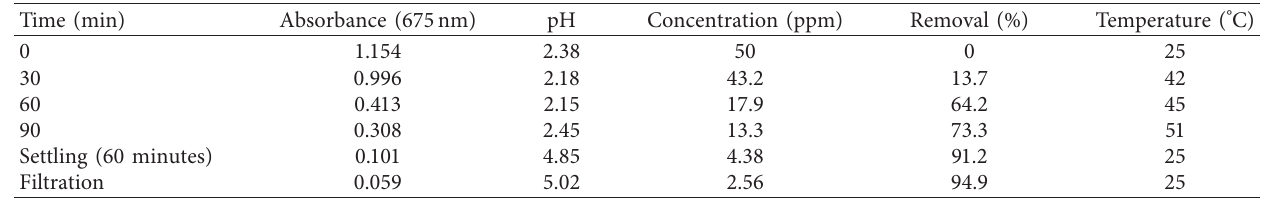
Figure 4: (a) Plot of pH with respect to time over 250min period. (b) Plot of absorbance with respect to time over 250min period. (c) Plot of percent removal with respect to time over 250min period. Table 2: Different characteristic values of red dye in acidic